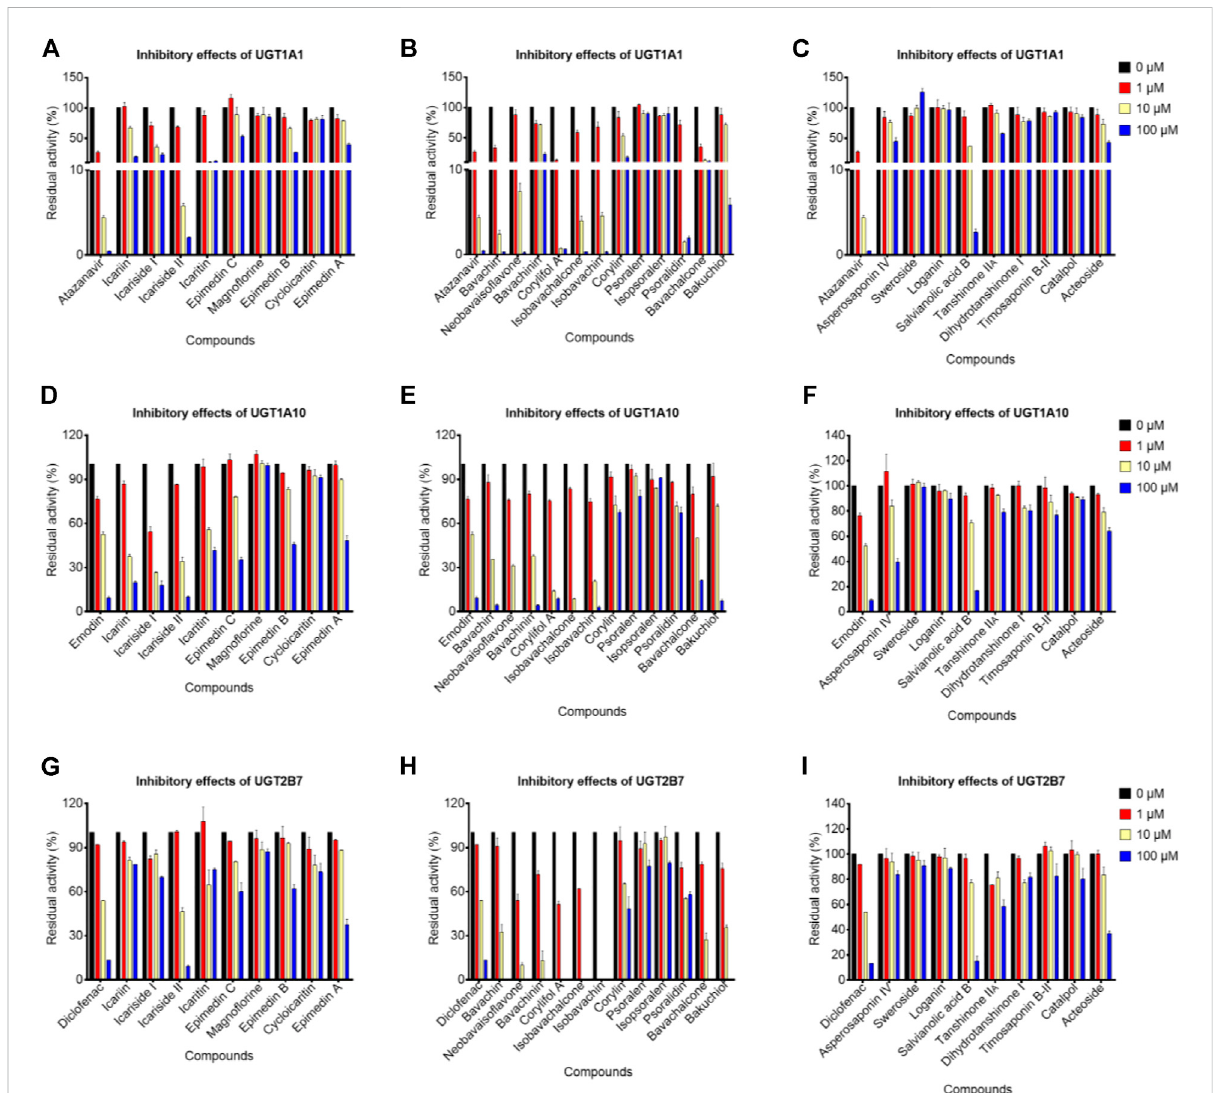
FIGURE 3 Inhibitory effects of potential bioactive compounds toward UGT1A1, UGT1A10, and UGT2B7 enzymes. (A) , (D) , and (G) represented the inhibitory effects of prenylated fl avanol glycosides from Epimedium brevicornu Maxim.; (B) , (E) , and (H) represented the inhibitory effects of prenylated fl avonoids and coumarins from Psoralea corylifolia L.; (C) , (F) , and (I) represented saponins from Dipsacus asper Wall. ex Henry and Anemarrhena asphodeloides Bge., tanshinones from Salvia miltiorrhiza Bge., and other compounds from Rehmannia glutinosa Libosch. The probe substrates were incubated at 37 ° C in the absence (control, 0 μ M) and presence of tested compounds (1, 10, and 100 μ M). Emodin, atazanavir, and diclofenac were considered as positive controls for UGT1A10, UGT1A1, and UGT2B7, respectively. Data were represented as the mean ± standard deviation of